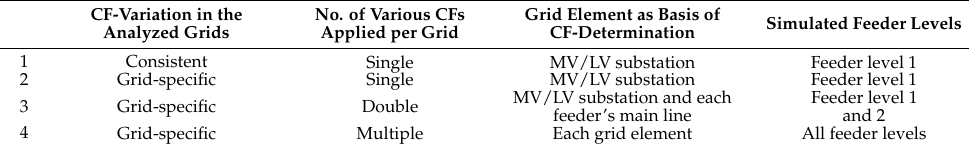
Table 5. Evaluated approaches to applying coincidence factors (CF). CF-Variation in the No. of Various CFs Grid Element as Basis of Analyzed Grids Applied per Grid CF-Determination Simulated Feeder